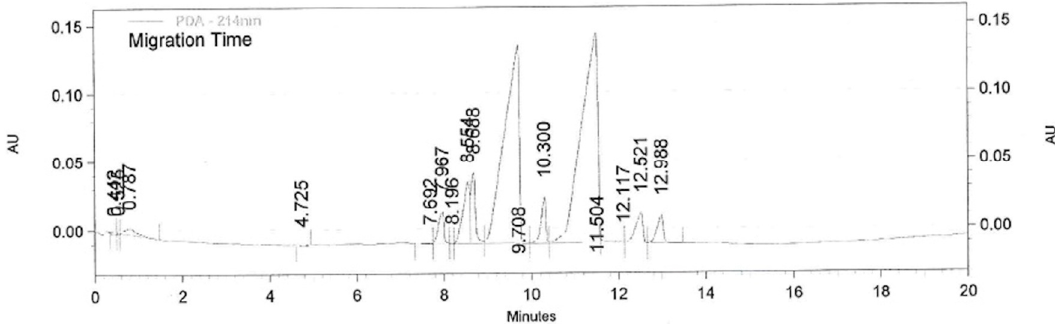
Figure 2. Electropherogram from the kinetic resolution of clenbuterol, catalysed by CALA with vinyl butanoate in tetrahydrofuran. t R ( R )-Clenbuterol 9.70 min, t R ( S )-clenbuterol at 11.50 min, and the butanoic esters ( R ) - and ( S )-clenbuterol at t R 12.52 min and t R 12.98 min, respectively.